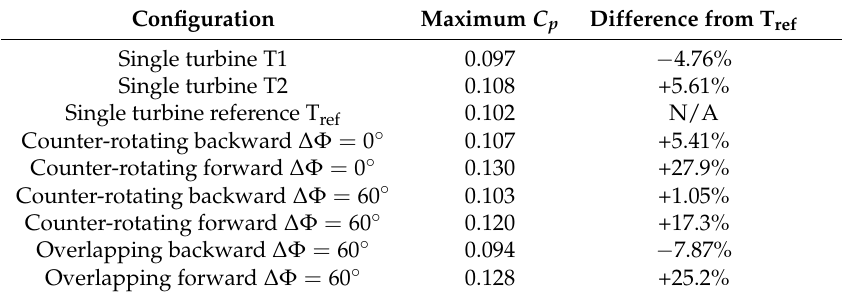
Table 1. Comparison of each configuration maximum recorded power